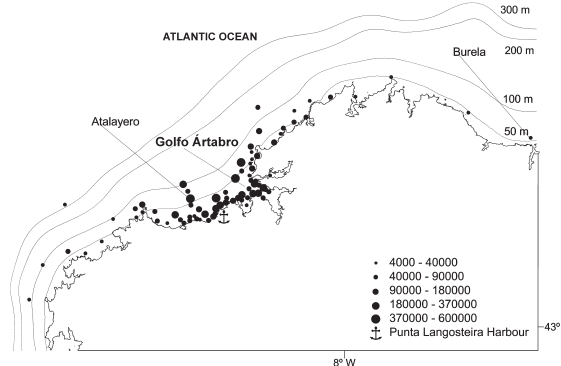
Fig . 3. – Fishing grounds exploited by the studied fleets and total revenue (in €) derived from their commercial exploitation in 2004.